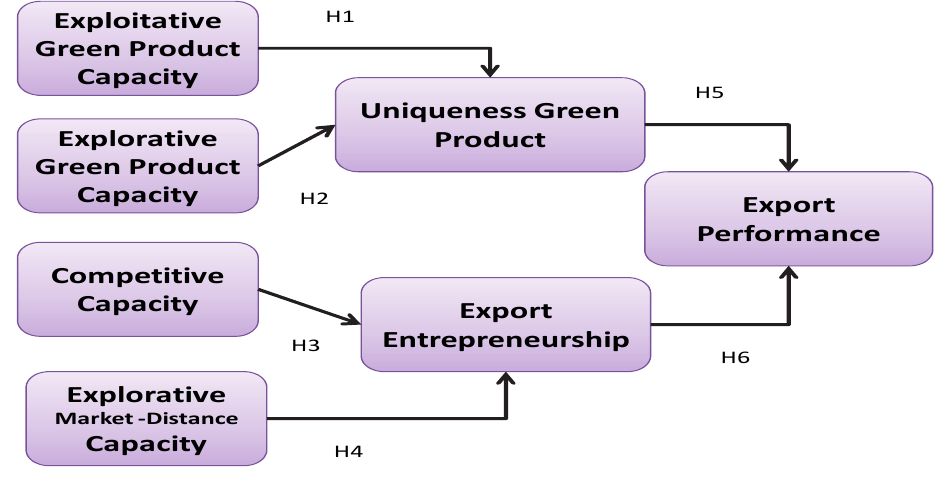
Fig. 1. The research framework